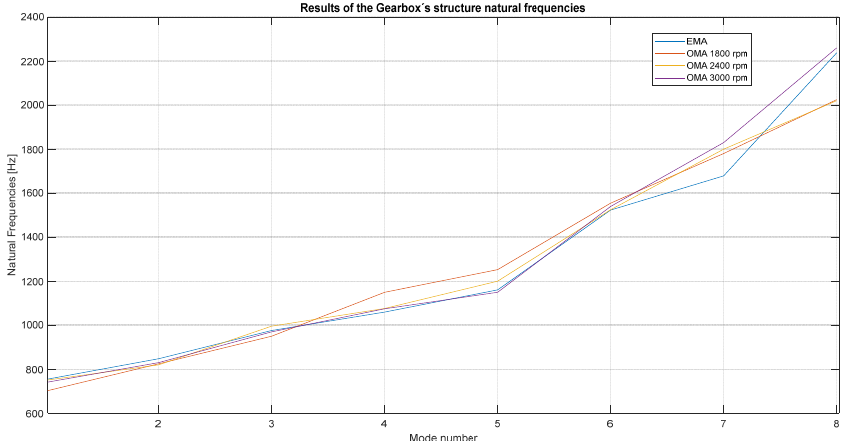
Figure 12. Comparison of the gearbox’s FRFs, with eight modes at varying speeds (1800, 2400, and 3000 rpm).